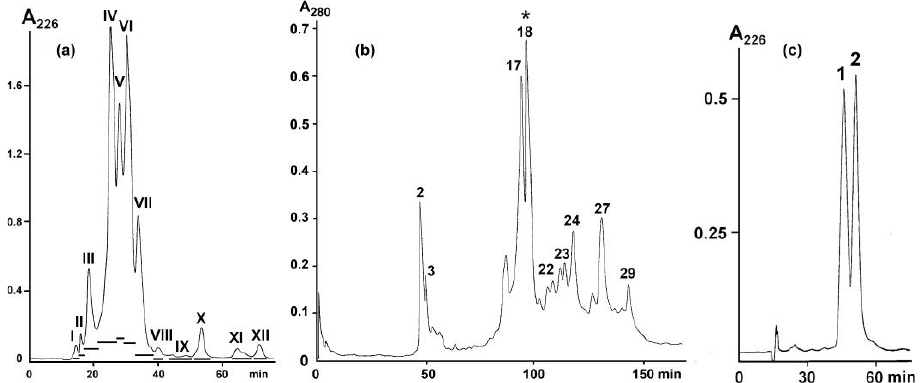
Figure 1. Separation of B. multicinctus venom. ( a ) Separation of the crude venom by gel-filtration chromatography on Superdex 75 column. ( b ) Separation of active fraction IV using ion-exchange chromatography on HEMA 1000 CM column. The asterisk indicates the active fraction. ( c ) Fraction 18 was separated into individual components by RP-HPLC using Jupiter C18 column.